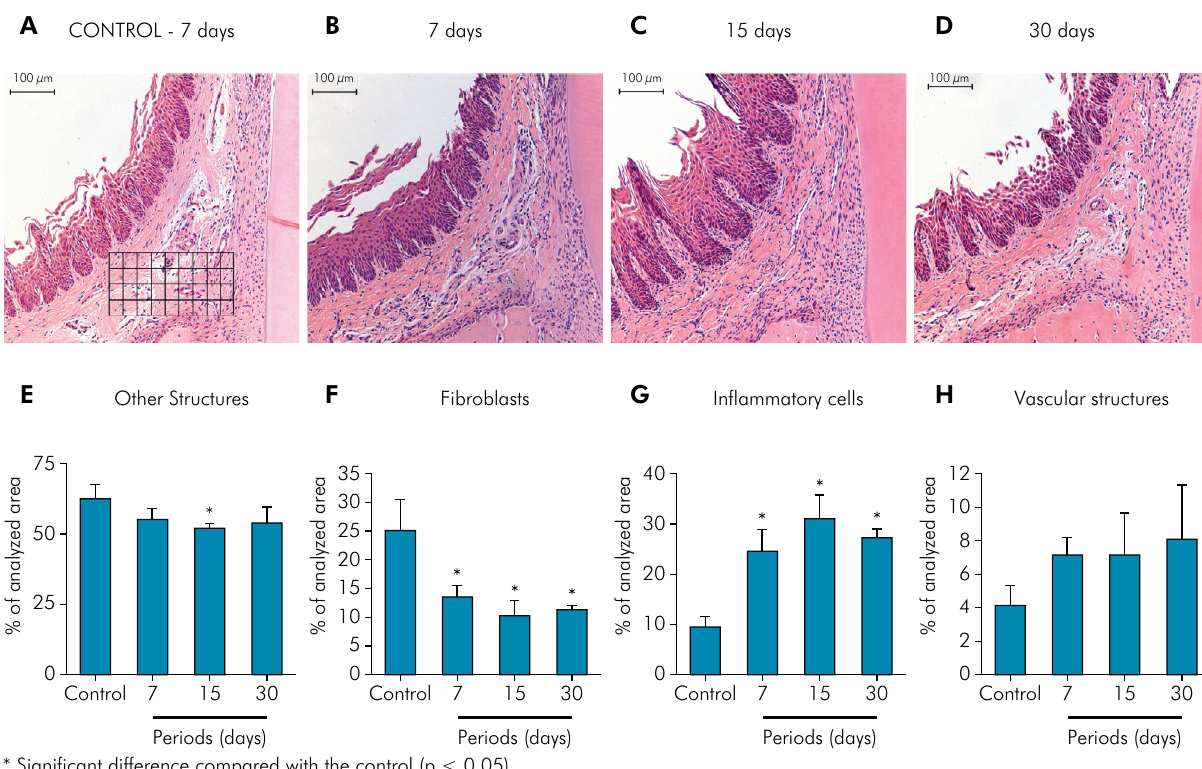
Figure 1. Photomicrographs of sections of the bone crest area in the control (A) and experimental groups (B, C, D) were analyzed. A single representative image of the control group is shown, as no important changes were noted in this group during the experimental period (data not shown). The presence of inflammatory cells (G), vascular structures (H), fibroblasts (F), and other structures (E) in a 32,400- μ m 2 area was analyzed using a point-counting technique, revealing increases in inflammatory cell density and vascular structures and decreases in the number of fibroblasts and other structures in diseased samples in all experimental periods. Inflammation was significantly more severe in the experimental groups than in the control